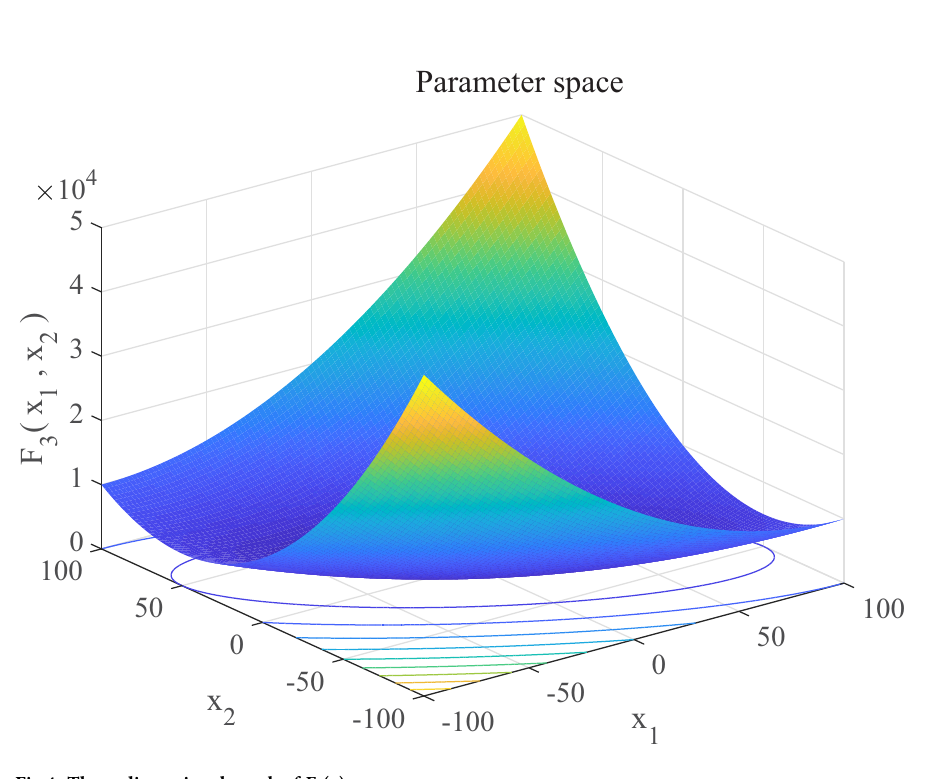
Fig 4. Three-dimensional graph of F 3 ( x